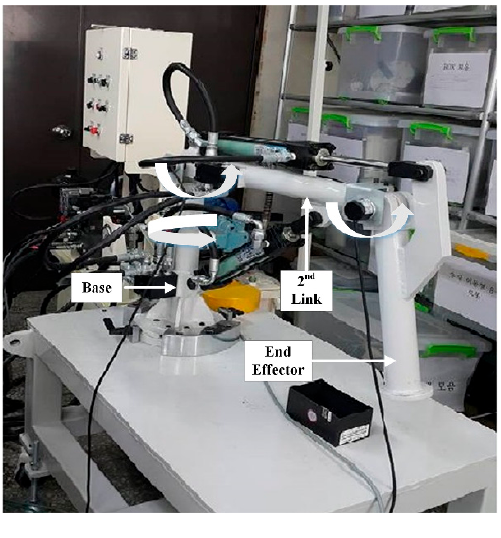
Figure 7. Slave device.